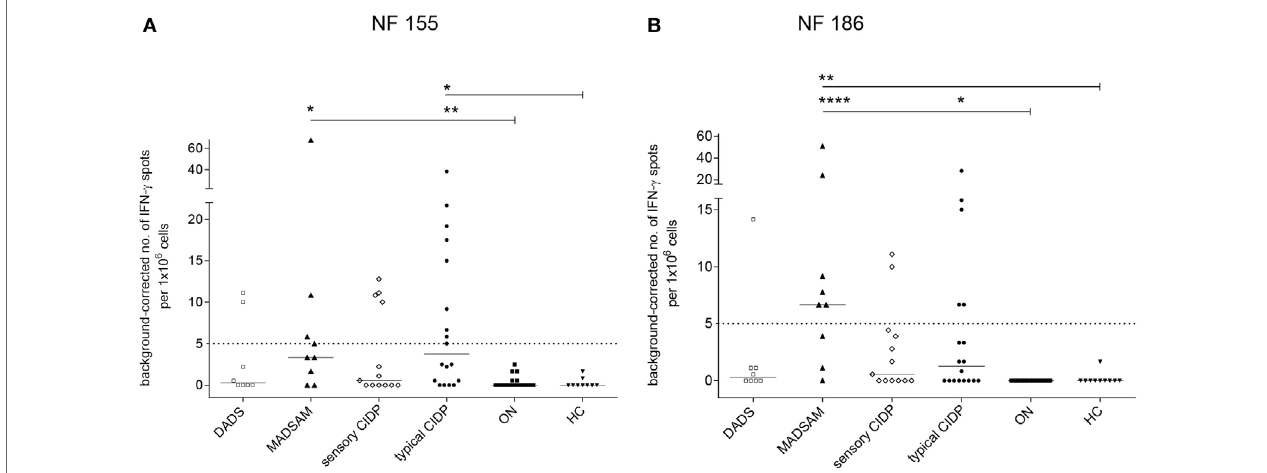
FigUre 1 | Autoreactive T cell responses against neurofascin antigens are elevated in chronic inflammatory demyelinating polyneuropathy (CIDP) subtypes compared to controls. Frequency of peripheral antigen-specific T cell responses in patients with distal acquired demyelinating polyneuropathy (DADS) ( n = 8), multifocal acquired demyelinating sensory and motor polyneuropathy (MADSAM) ( n = 9), sensory CIDP ( n = 13), typical CIDP ( n = 18), other non-immune polyneuropathy (ON) ( n = 19), and healthy control (HC) ( n = 9) measured by enzyme-linked immunospot assay. Lines at median. Background corrected interferon- gamma (IFN- γ ) spot forming cells per 1 × 10 6 peripheral blood monocytes against neurofascin (NF) 155 (a) and NF186 (B) (*** p < 0.001, ** p < 0.01, * p < 0.05; Dunn’s multiple comparisons test). (a) Cutoff was defined at spot forming unit (SFU) ≥ 5 with sensitivity of 44.4% and specificity of 100% based on receiver operating characteristics (ROC) analysis comparing typical CIDP and ON [area under the ROC curve (AUC) = 0.83 with 95% confidence interval of 0.7–0.96]. (B) Cutoff was defined at SFU ≥ 5 with sensitivity of 66.7% and specificity of 100%, based on ROC analysis comparing MADSAM and ON (AUC = 0.94 with 95% confidence interval of